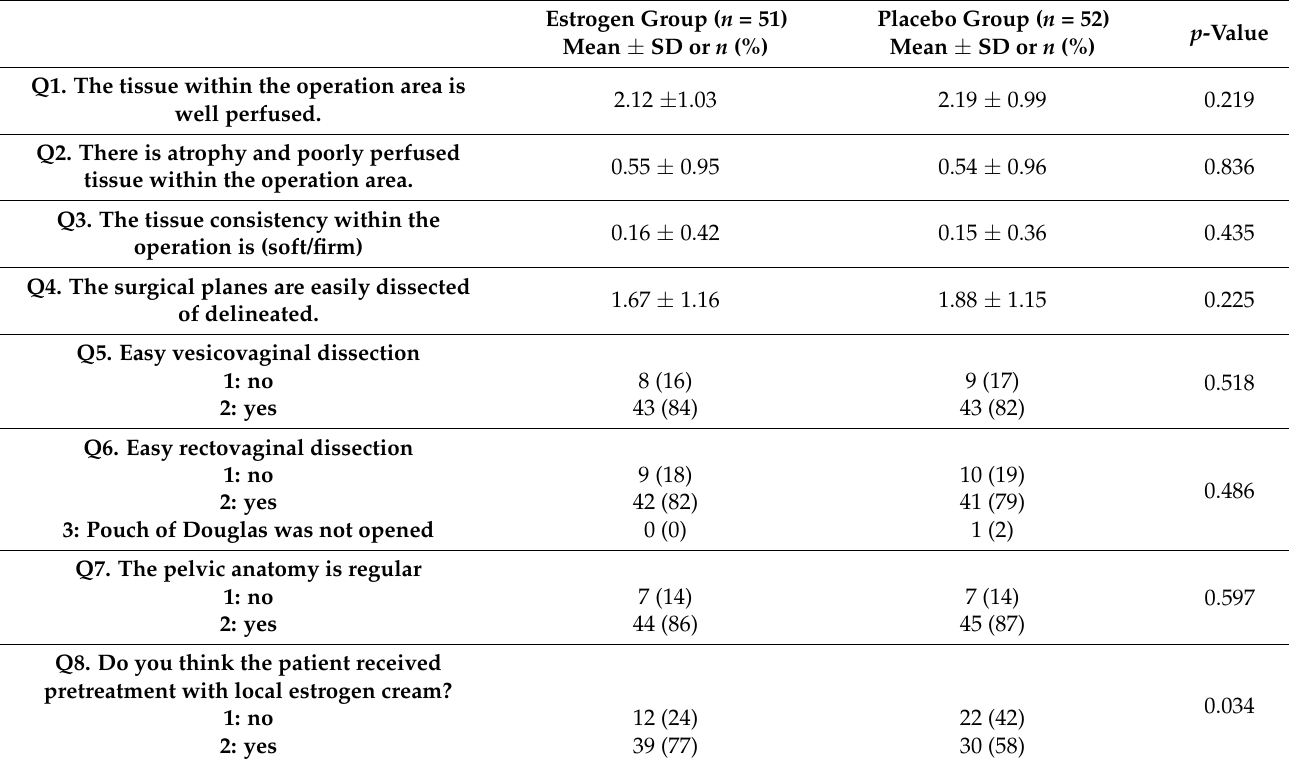
Table 2. Intraoperative subjective surgical assessment of the tissue quality in patients with estrogen or placebo pre-treatment.